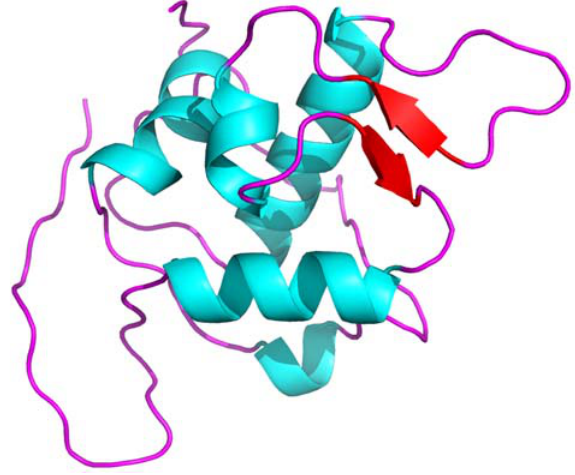
Figure 1: Structural and molecular view for the three-dimensional modeled functional MDM2 protein in Homo sapiens